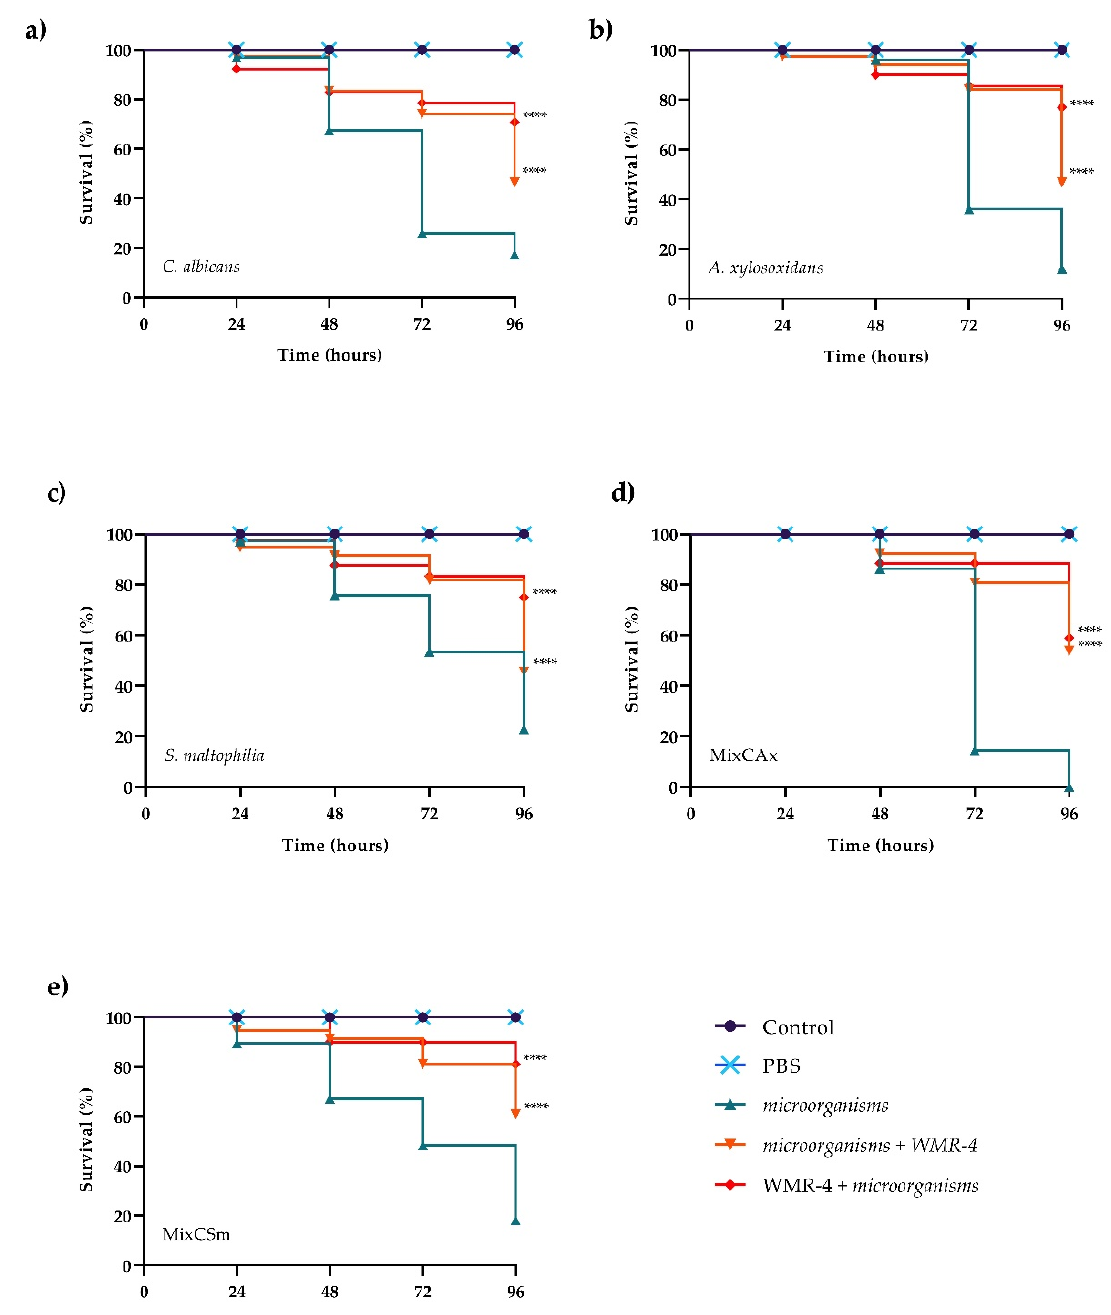
Figure 8. Kaplan–Meier plots of survival curves of G. mellonella larvae infected with C. albicans ( a ), A. xylosoxidans ( b ), S. maltophilia ( c ), CAx ( d ), CSm ( e ). The concentration of microorganisms was 1 ×